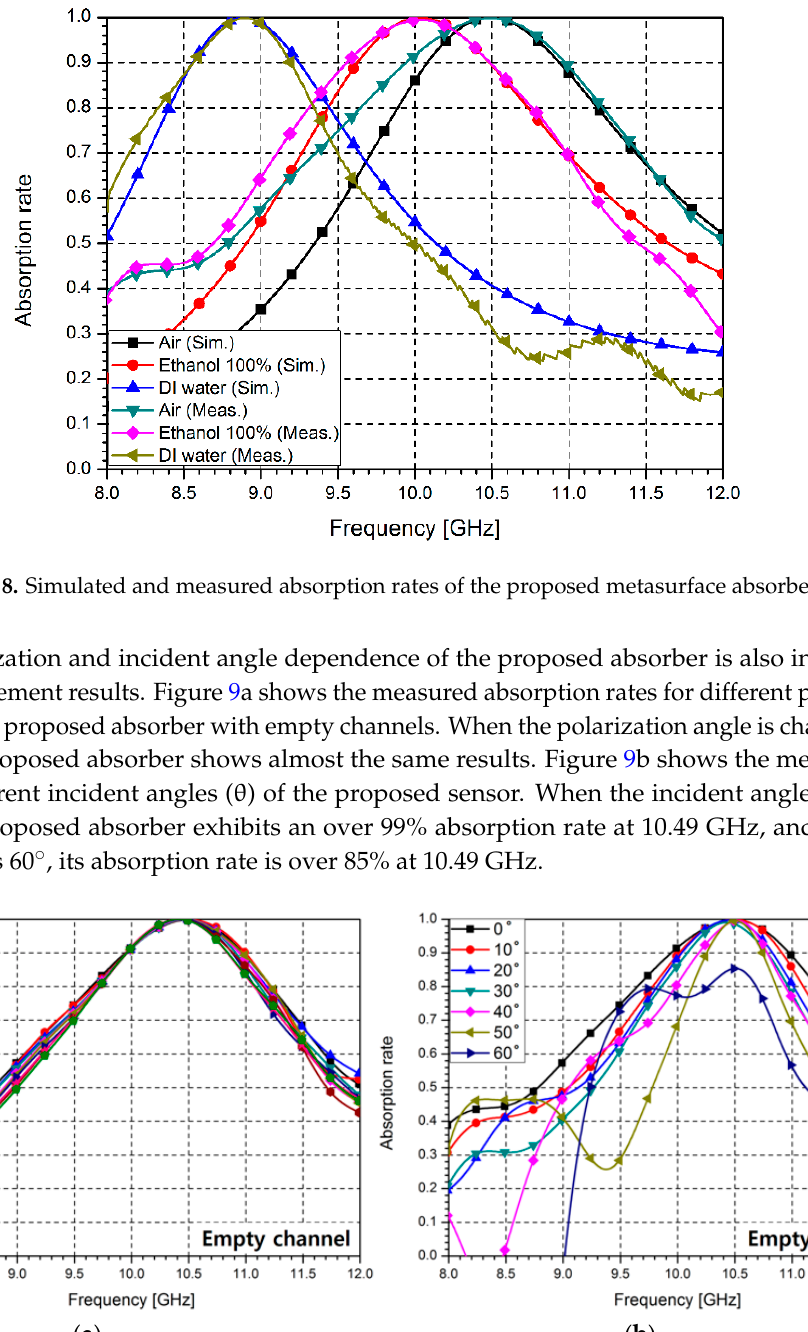
Figure 9. Measured absorption rates of the proposed absorber at different ( a ) polarization angles ( φ ) and ( b ) incidence angles ( θ ).